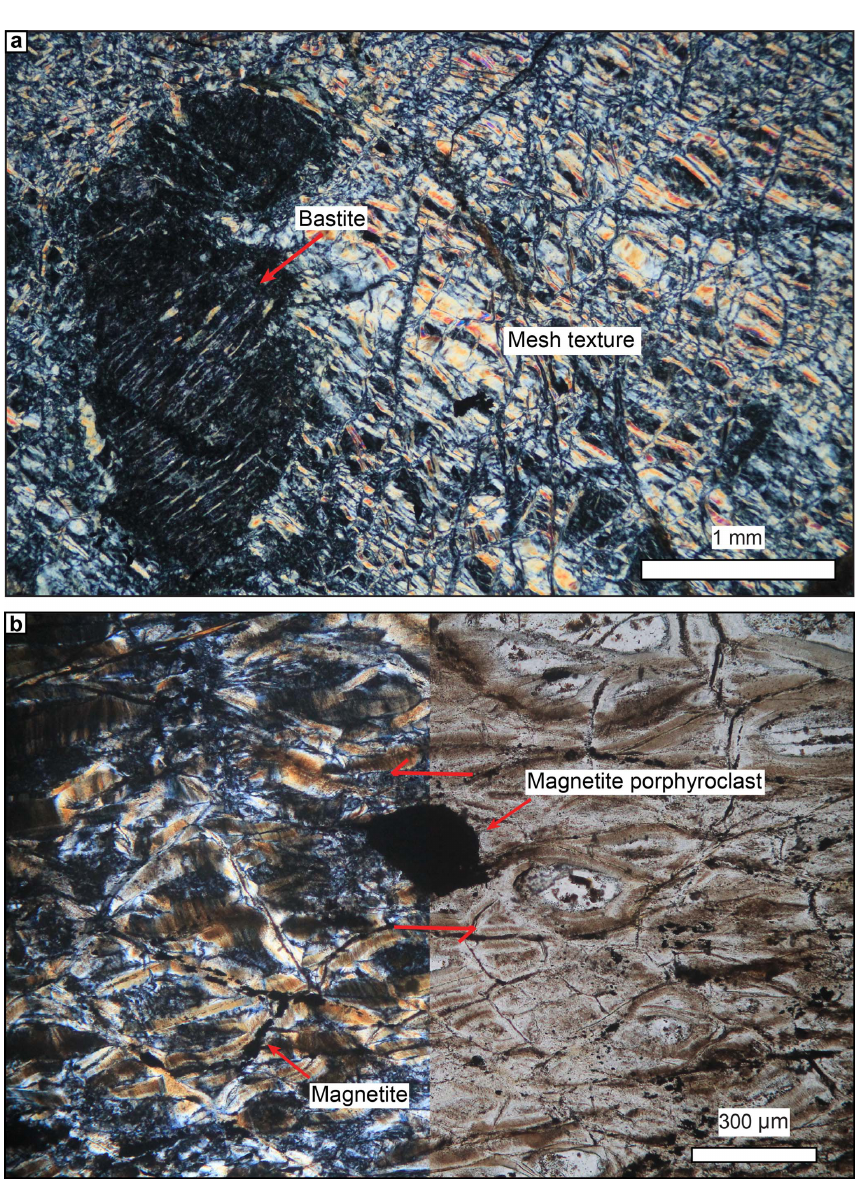
Figure 9. Serpentinite textures in pods and massive serpentinite domains. (a) Mesh-textured and bastite serpentinite from the centre of a serpentinite pod (location in Fig. 7). Optical microscope image in crossed-polarised light. (b) Sheared mesh-textured serpentinite in the initial stages of developing into “ribbon serpentinite” from within the large domain of massive serpentinite at Serpentine Saddle (location in Fig. 7) Optical microscope image in crossed-polarised light (left-hand side) and plane-polarised light (right-hand